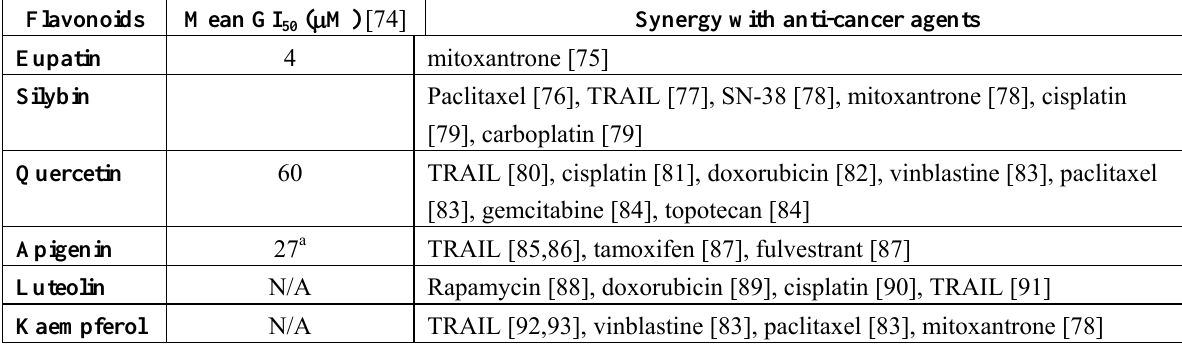
Table 2. Synergism between flavonoids and anticancer